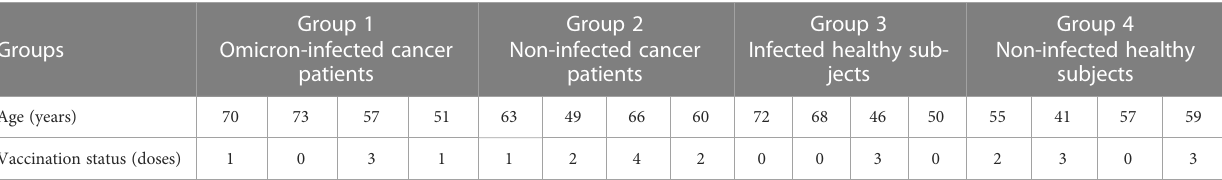
Vaccination status